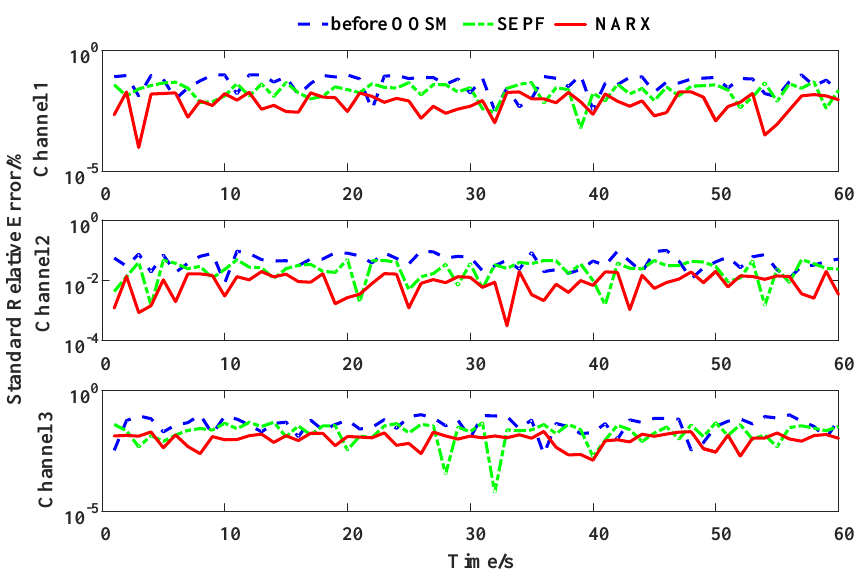
Figure 12. Relative errors of the 3rd harmonic identification with different OOSM methods of different channels.